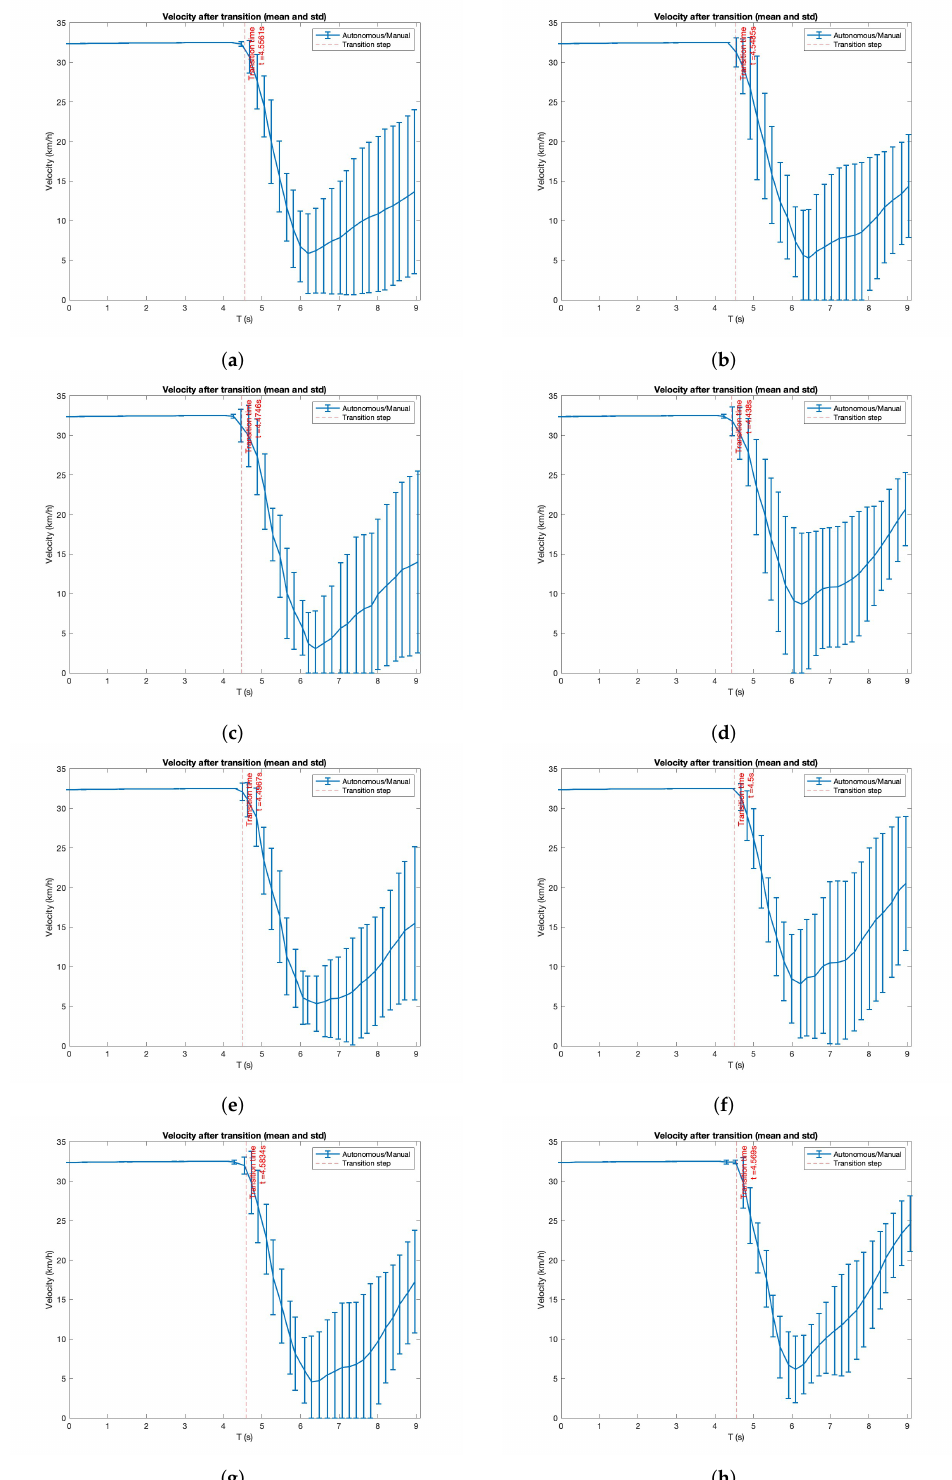
Figure 10. Velocity analysis after transition (mean and standard deviation). Transitions are split in au- tonomous to manual. ( a ) Experiment: ACC. Driver attention: focus. ( b ) Experiment: ACC + passing. Driver attention: focus. ( c ) Experiment: ACC. Driver attention: using the mobile phone. ( d ) Ex- periment: ACC + passing. Driver attention: using the mobile phone. ( e ) Experiment: ACC. Driver attention: reading. ( f ) Experiment: ACC + passing. Driver attention: reading. ( g ) Experiment: ACC. Driver attention: talking to passenger. ( h ) Experiment: ACC + passing. Driver attention: talking to